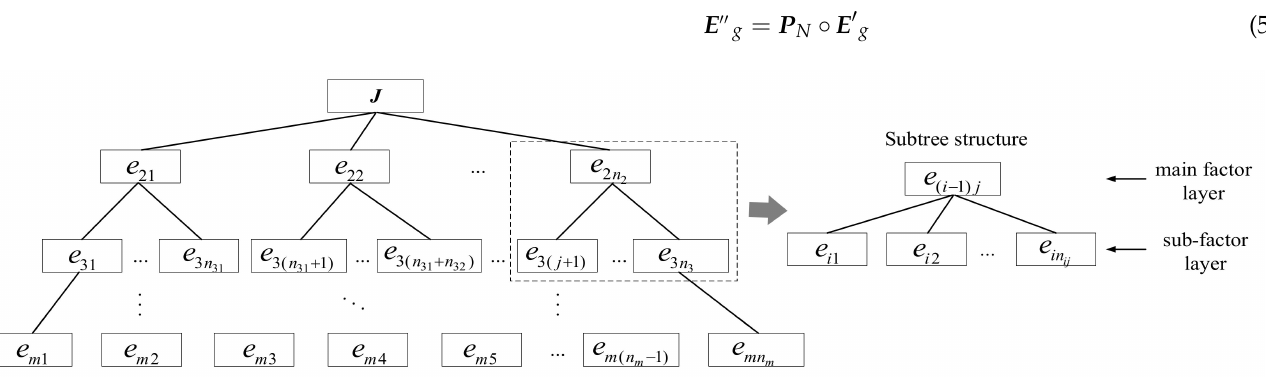
Figure 2. Hierarchical tree model without a